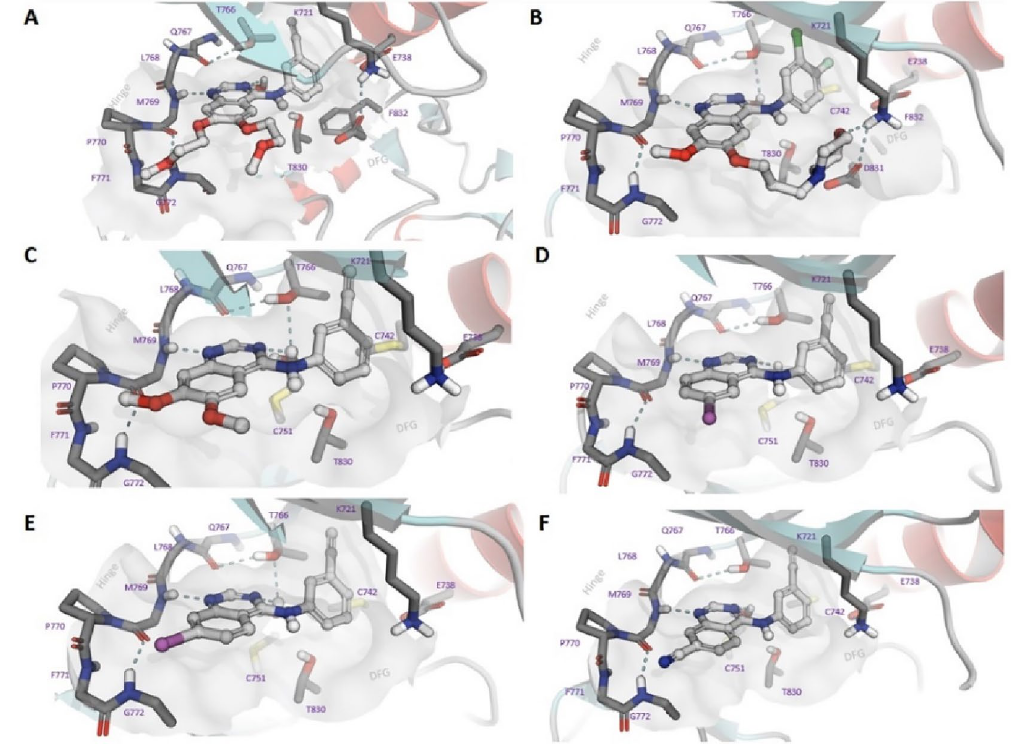
Figure 2. Docking of compounds in the EGFR ATP binding site (PDB:1M17): ( A ) erlotinib, ( B ) gefitinib, ( C ) 1 , ( D ) 9 , ( E ) 15 , ( F ) 17 showing key interactions with the hinge and hydrophobic pocket, along with the overall orientation of the quinazoline ring system.